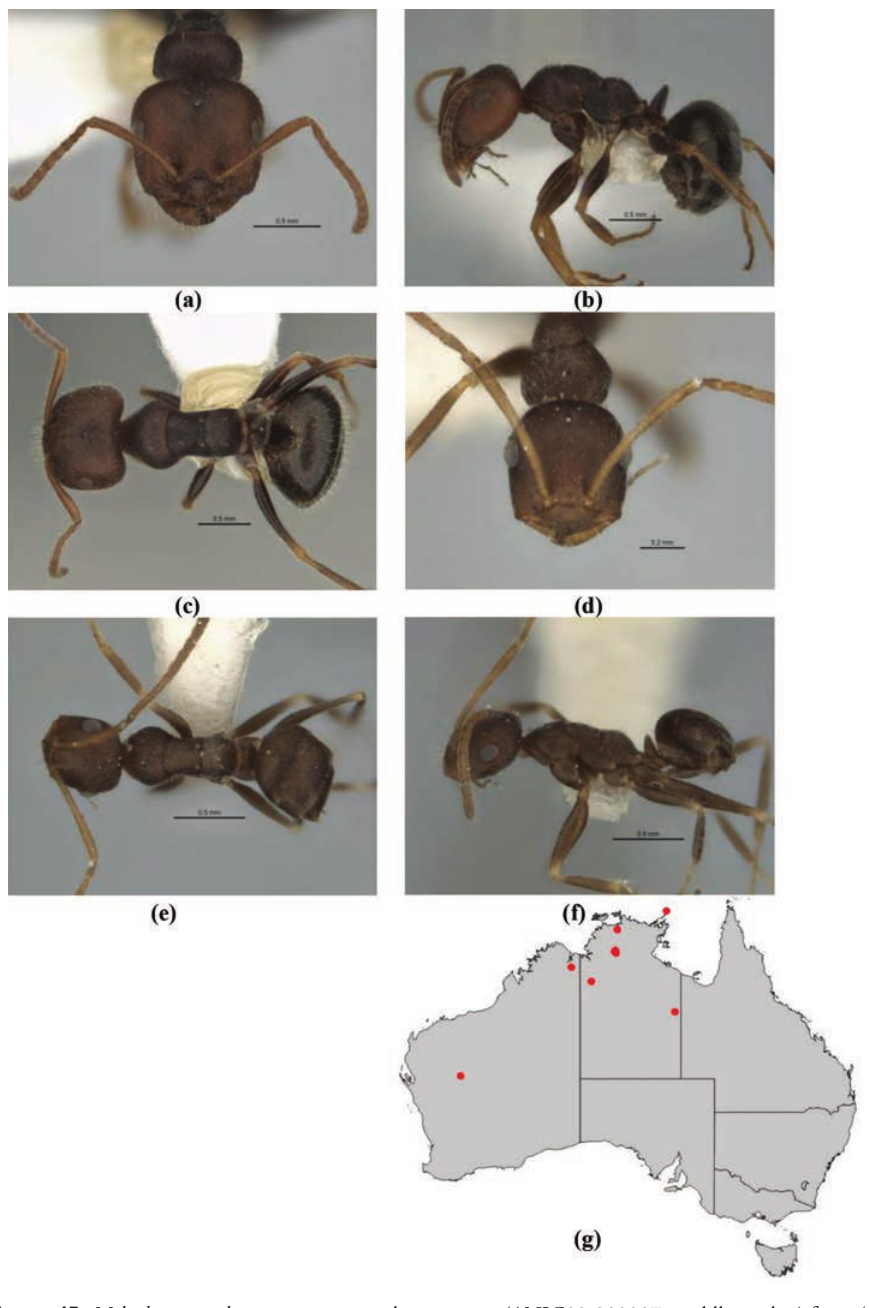
Figure 45. Melophorus postlei sp. n.: major worker paratype (ANIC32-900087–middle worker) frons ( a ), profile ( b ) and dorsum ( c ); minor worker holotype (ANIC32-900081) frons ( d ), profile ( e ) and dor- sum ( f ); distribution map for the species ( g ). Low resolution scale bars: 0.5 mm ( a–c, e, f ); 0.2 mm ( d